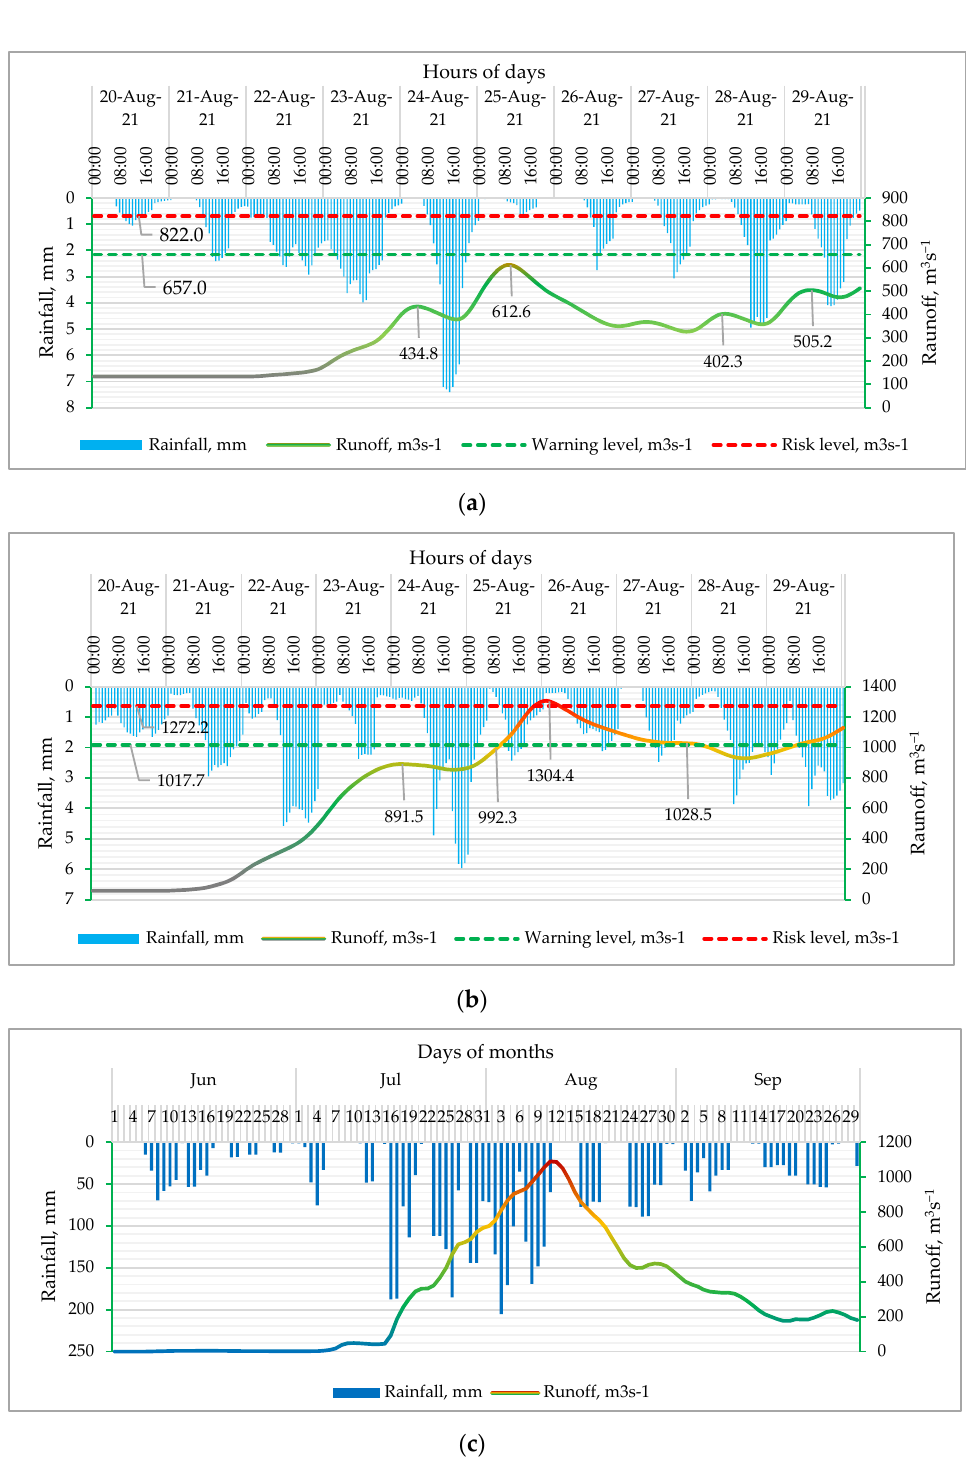
Figure 8. Real-time ((20–29 August 2021 hourly data) and seasonal (daily data from June to September 2021) rainfall and runoff forecasts for selected river stations. Therefore, ( a ) shows real-time rainfall and runoff forecasts for Awash-Hombole River, ( b ) real-time rainfall and runoff forecasts for Gibe-Tolai, and ( c ) seasonal rainfall and runoff forecasts for Awash-Hombole River station.